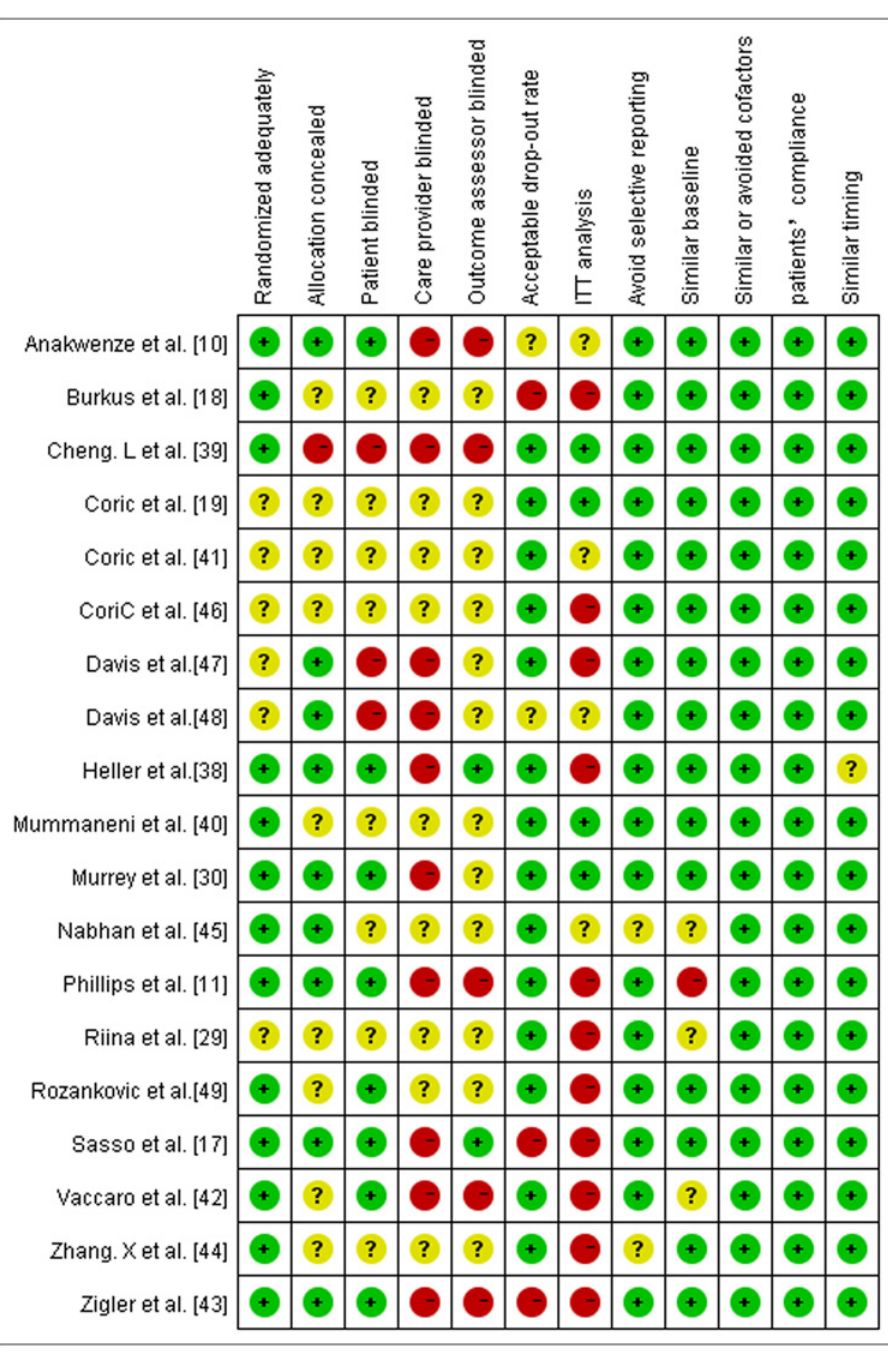
Fig 2. The risk of bias for the included studies was assessed in our